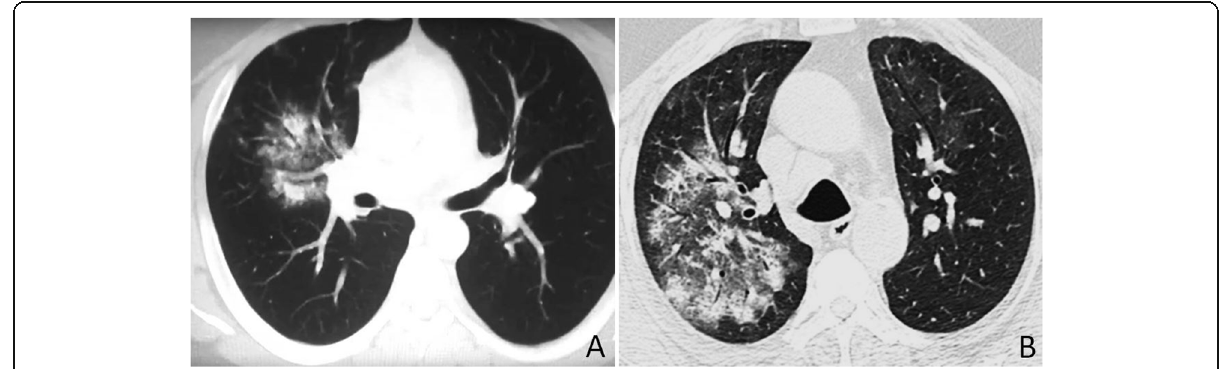
Fig. 4 COVID-19 and cryptogenic pneumonia misdiagnosed as COVID-19. a Axial CT image obtained from a 33-year-old man with positive PCR test for COVID-19 shows area of clearing consolidation with central ground-glass density “ reversed halo sign ” in the right lung. b Cryptogenic organizing pneumonia in a 55-year-old man with history of chest infection not responding to multiple courses of antibiotics; axial CT image shows reversed halo sign in the right lung with small areas of GGO in the left lung. Transbronchial biopsy showed findings of